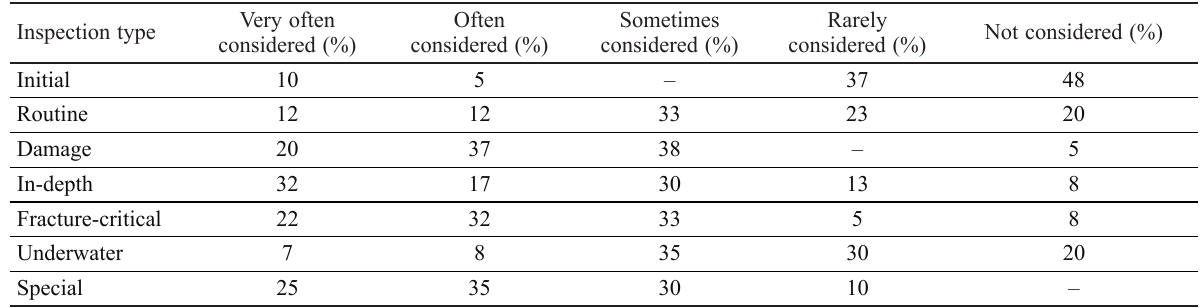
Table 1. NDT usage by inspection type Inspection